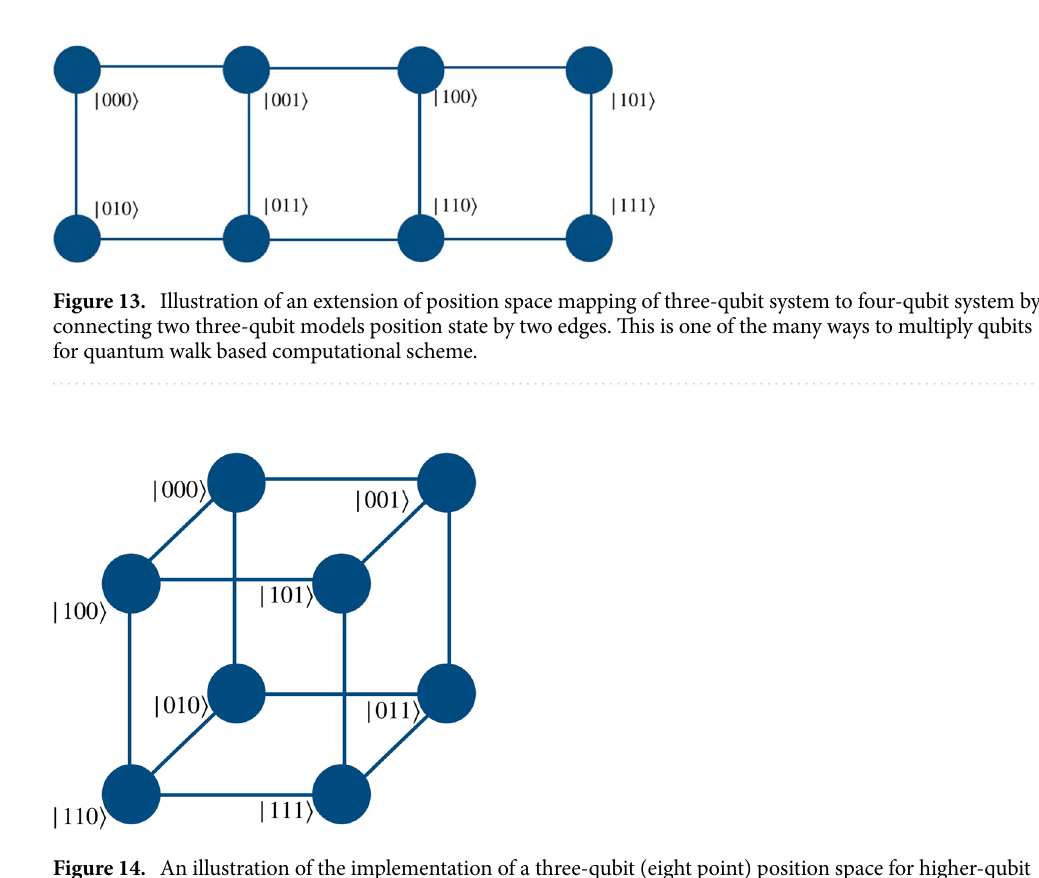
0 of the real particle. | �